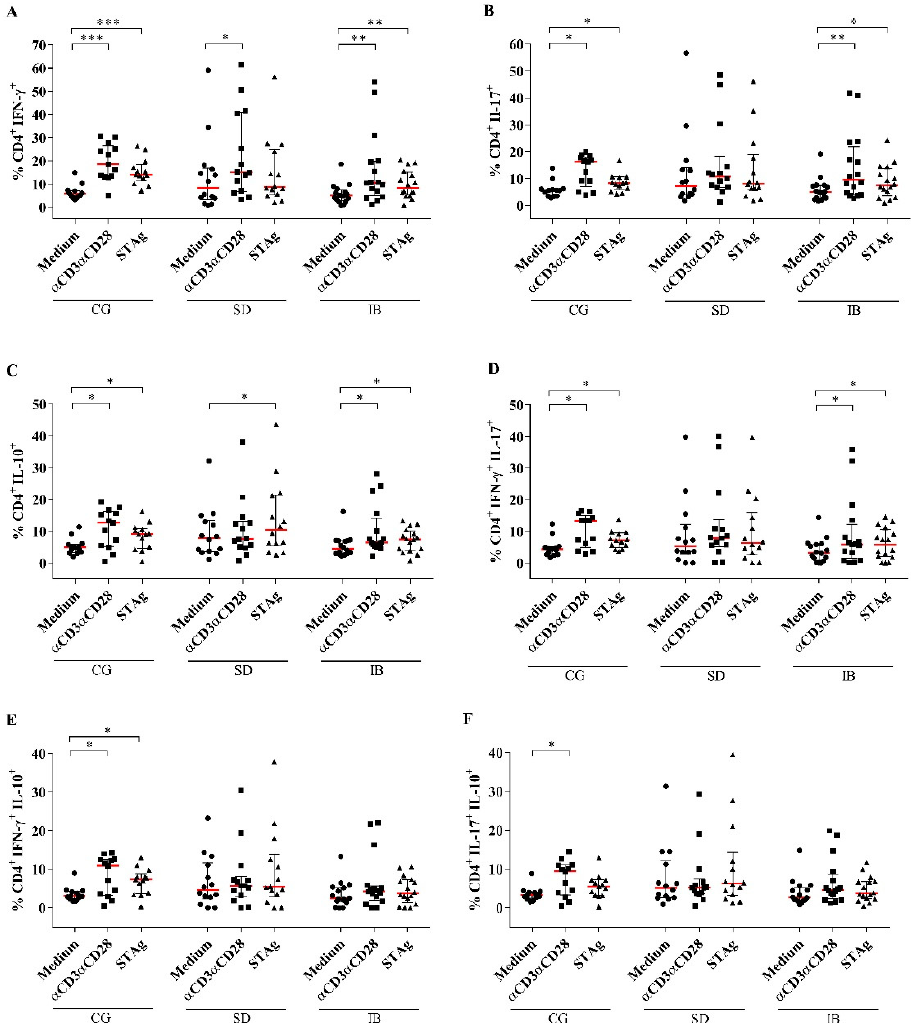
Figure 5. CD4 + T lymphocyte profiles, assessed by the expression of IFN- γ , IL-17, and IL-10 cytokines. ( A ) Percentage of CD4 + IFN- γ + , ( B ) CD4 + IL-17 + , ( C ) CD4 + IL-10 + , ( D ) CD4 + IFN- γ + IL-17 + , ( E ) CD4 + IFN- γ + IL-10 + , and ( F ) CD4 + IL-17 + IL-10 + after 96 h of stimulus with anti-CD3 and anti-CD28, STAg, and absence of stimulus in the CG and SD and IB groups, by flow cytometry. Analysis between stimuli by Wilcoxon and among groups by Kruskal–Wallis. The horizontal bars represent the medians with interquartile ranges. Statistically significant data, * p < 0.05, ** p < 0.005, and *** p < 0.0005.